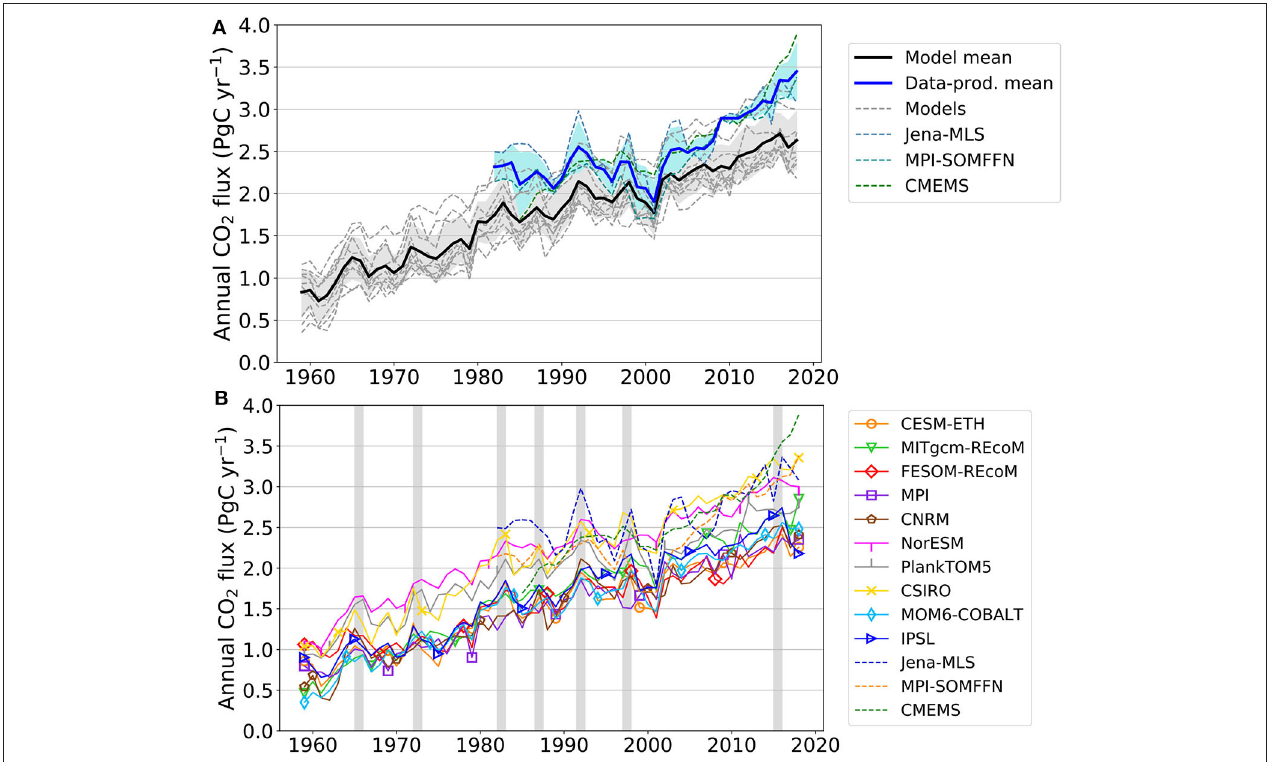
FIGURE 3 | Annual air-sea CO 2 flux from Global Ocean Biogeochemistry Models (GOBMs) and data-products used in the Global Carbon Budget 2019, after applying bias and area-corrections and river flux adjustment of 0.78 PgC yr − 1 ( Resplandy et al., 2018). (A) Mean of model ensemble and data-product ensemble as thick lines, individual models and data-products as thin dashed lines. (B) Individual models and data-products in color. Gray bars indicate strong and very strong El Niño events with the extended Multivariate ENSO index (MEI) being above 1.5 for at least 3 months in a row ( Wolter and Timlin, 2011). Positive numbers indicate a flux into the